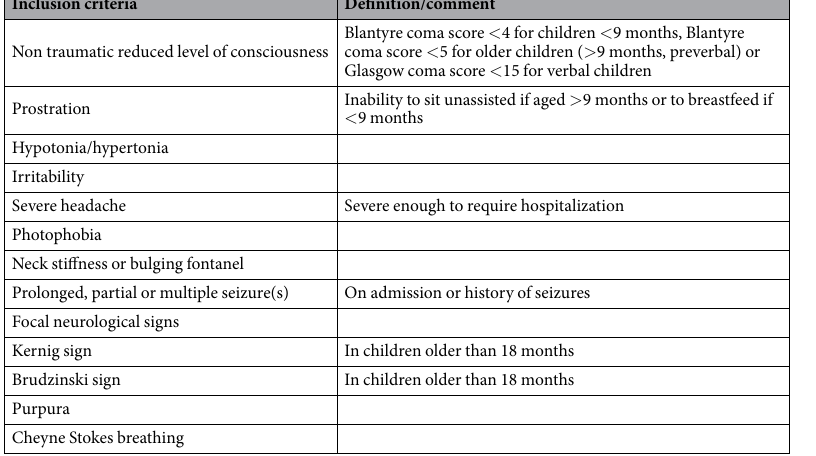
Table 1. Signs of CNS involvement (inclusion